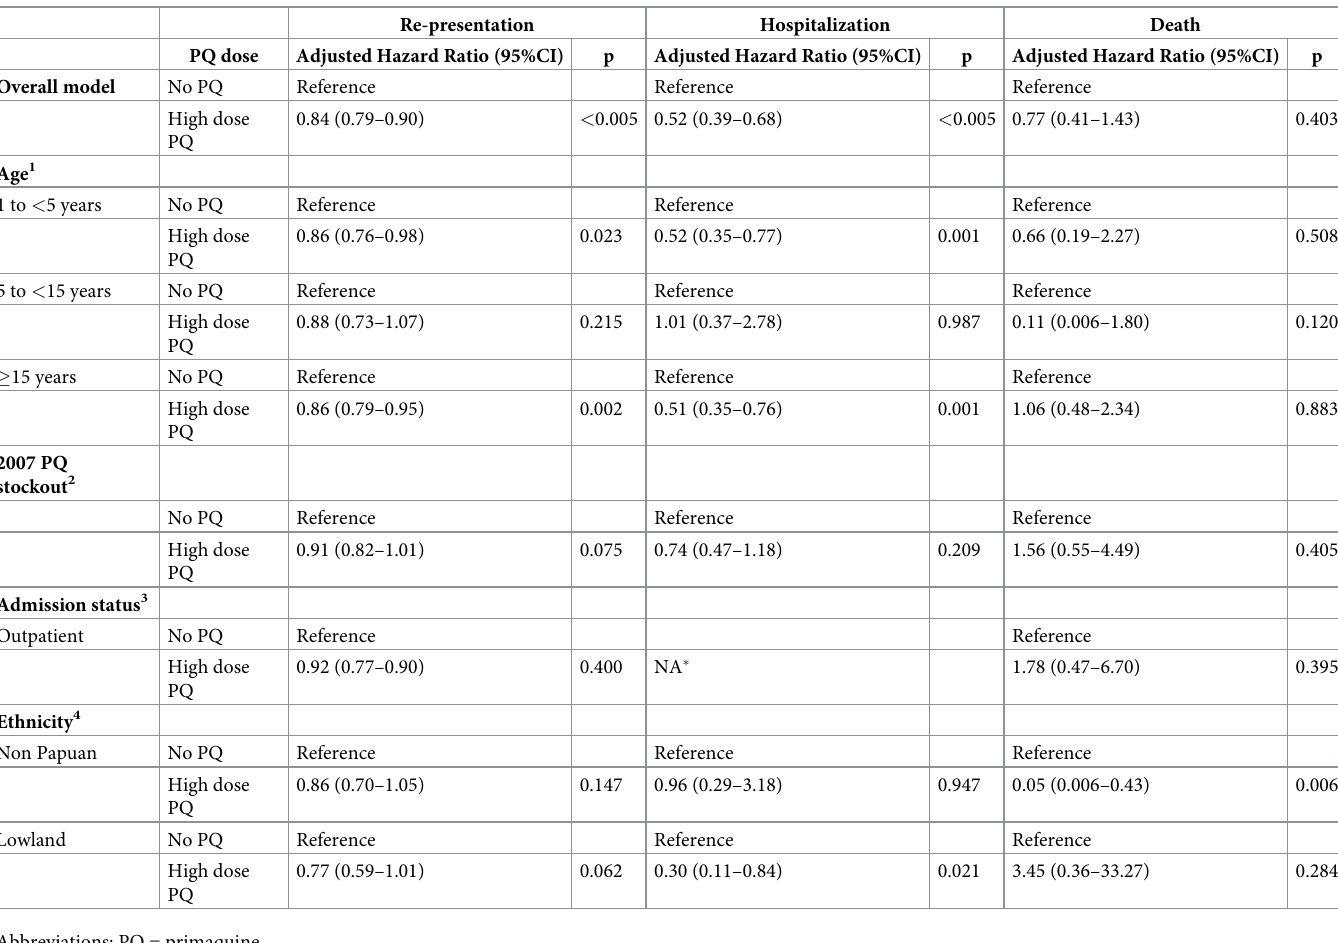
Table 3. Subgroup analyses of high dose PQ versus no PQ for all-cause re-presentation, hospitalization and death within 30